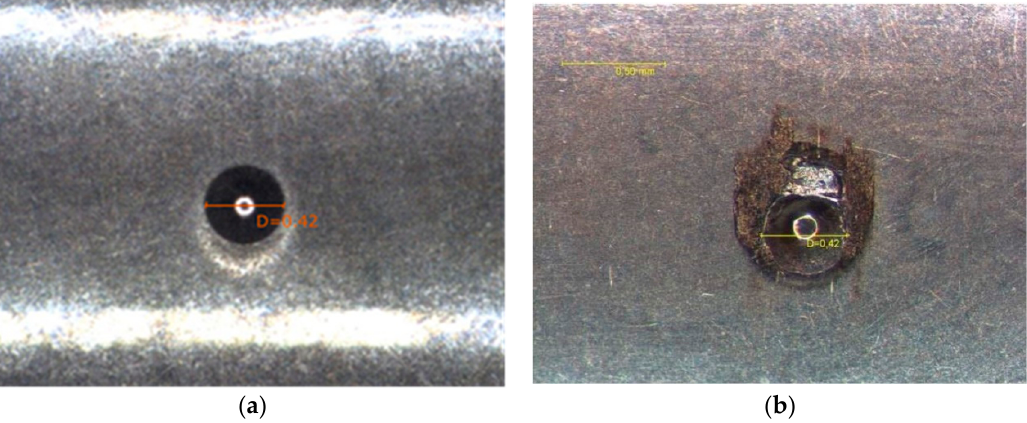
Figure 3. The damage (a conical indentation) on the rolling element as obtained through a Rockwell tool ( a ) and its evolution after 19 h at various load and speed conditions ( b ). Dimensions in mm. The raw data are further described in [12] and can be downloaded at ftp://ftp.polito.it/people/DIRG_BearingData/.